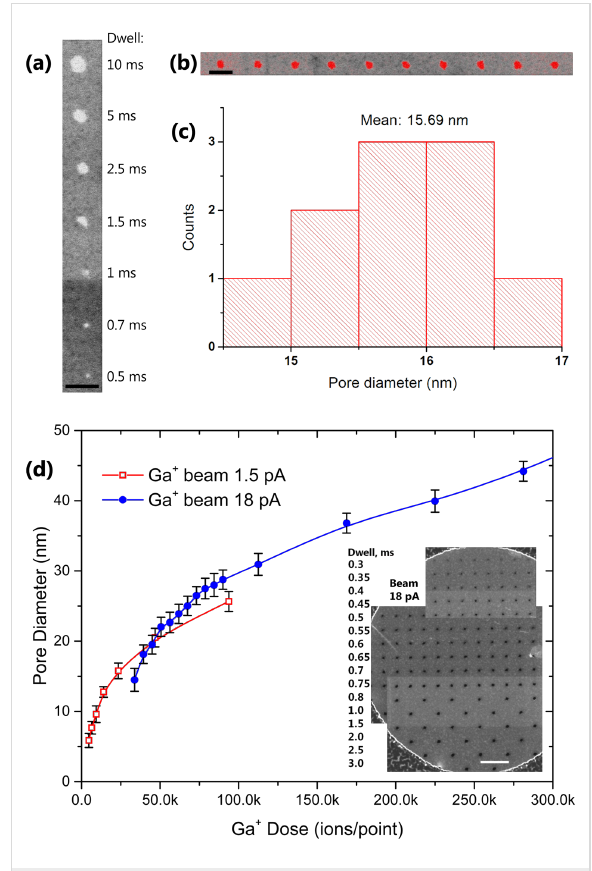
Figure 1: (a) STEM-BF image of a graphene membrane perforated with a 1.5 pA Ga-FIB. Pores diameter increases for longer dwell time. Scale bar is 50 nm. (b) Ten pores created under the same conditions, beam current 1.5 pA and dwell time 2.5 ms per spot. The red color in- dicates the pore areas used to calculate the diameters. Scale bar is 50 nm. (c) A histogram of pore diameters extracted from (b). (d) Graphene pore diameter dependency on Ga-FIB dose for different beam currents. Dots represent extracted mean values from the corre- sponding dose histograms, as shown in (c). Lines are drawn for visual guidance. Inset shows STEM-DF image of perforated graphene with 18 pA Ga-FIB. Pores within the same row are created with the same dwell time, indicated to the left of the image. Scale bar is 200 nm.